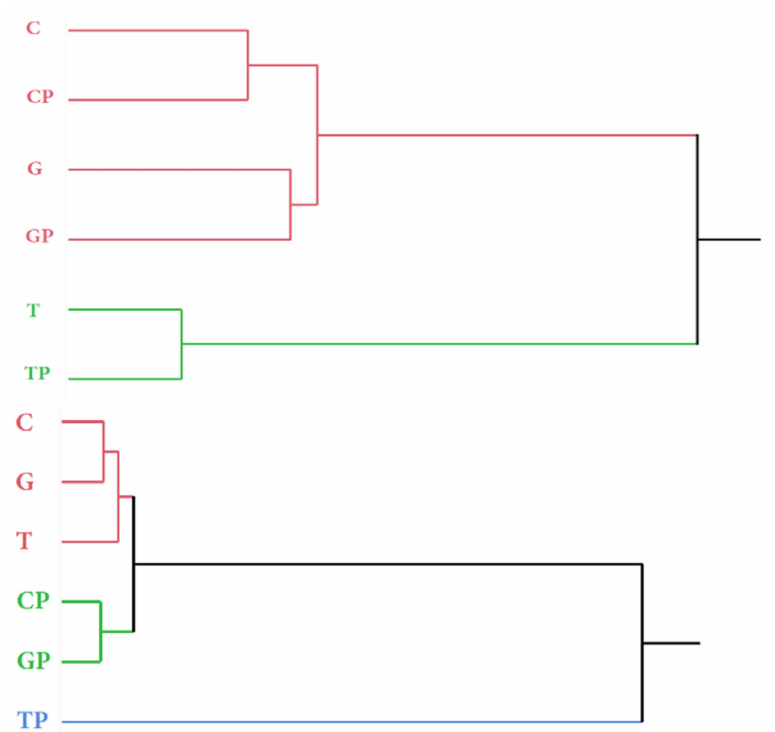
Figure 5. HCA of the GC-MS data relating to wines from the two different protocols analysed at racking at ends of